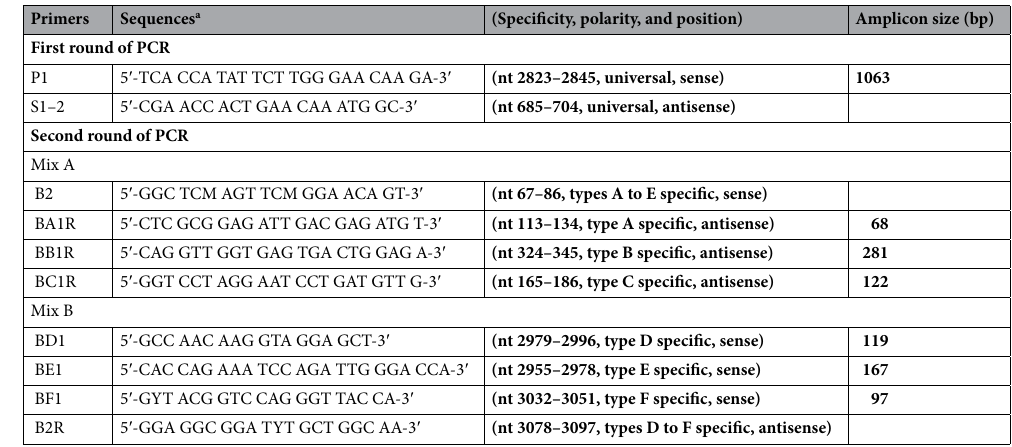
Table 1. Primer sequences used for HBV genotyping in this study. a An “M” indicates a nucleotide that may be either A or C; a “Y” indicates a nucleotide that may be either C or T nt,